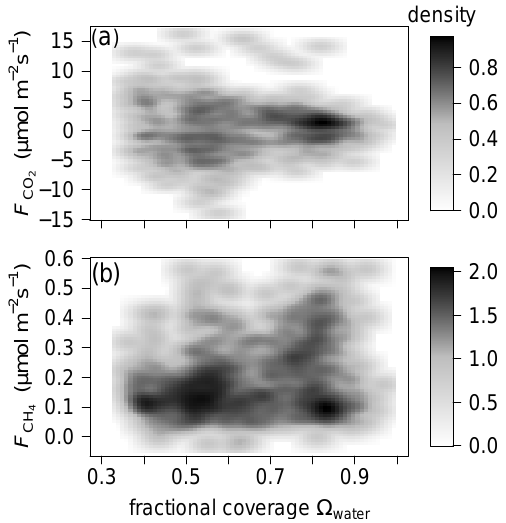
within the EC source area on the measured fluxes of CO 2 and CH 4 (15 May to 14 September 2013). The abundances of CO 2 and CH 4 fluxes in dependence on (cid:127) water are illustrated by a smoothed two- dimensional kernel density estimate. The variability of CO 2 flux rates decreased with increasing (cid:127) water , whereas the variability of the CH 4 flux